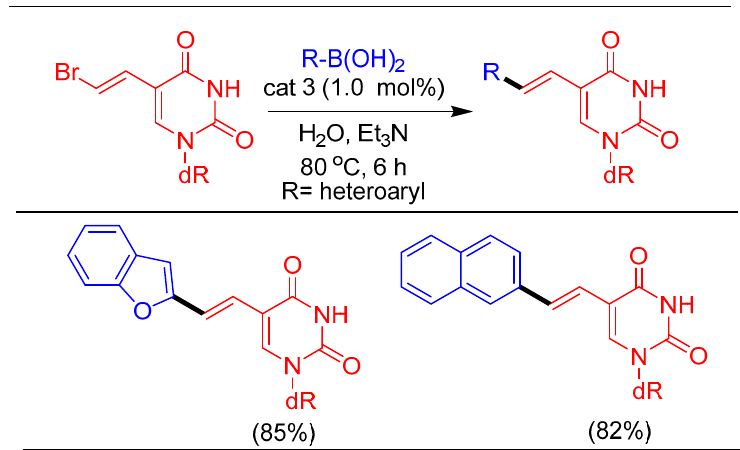
Scheme 6. Synthesis of fluorescent nucleosides following Suzuki–Miyuara reaction of BVDU.